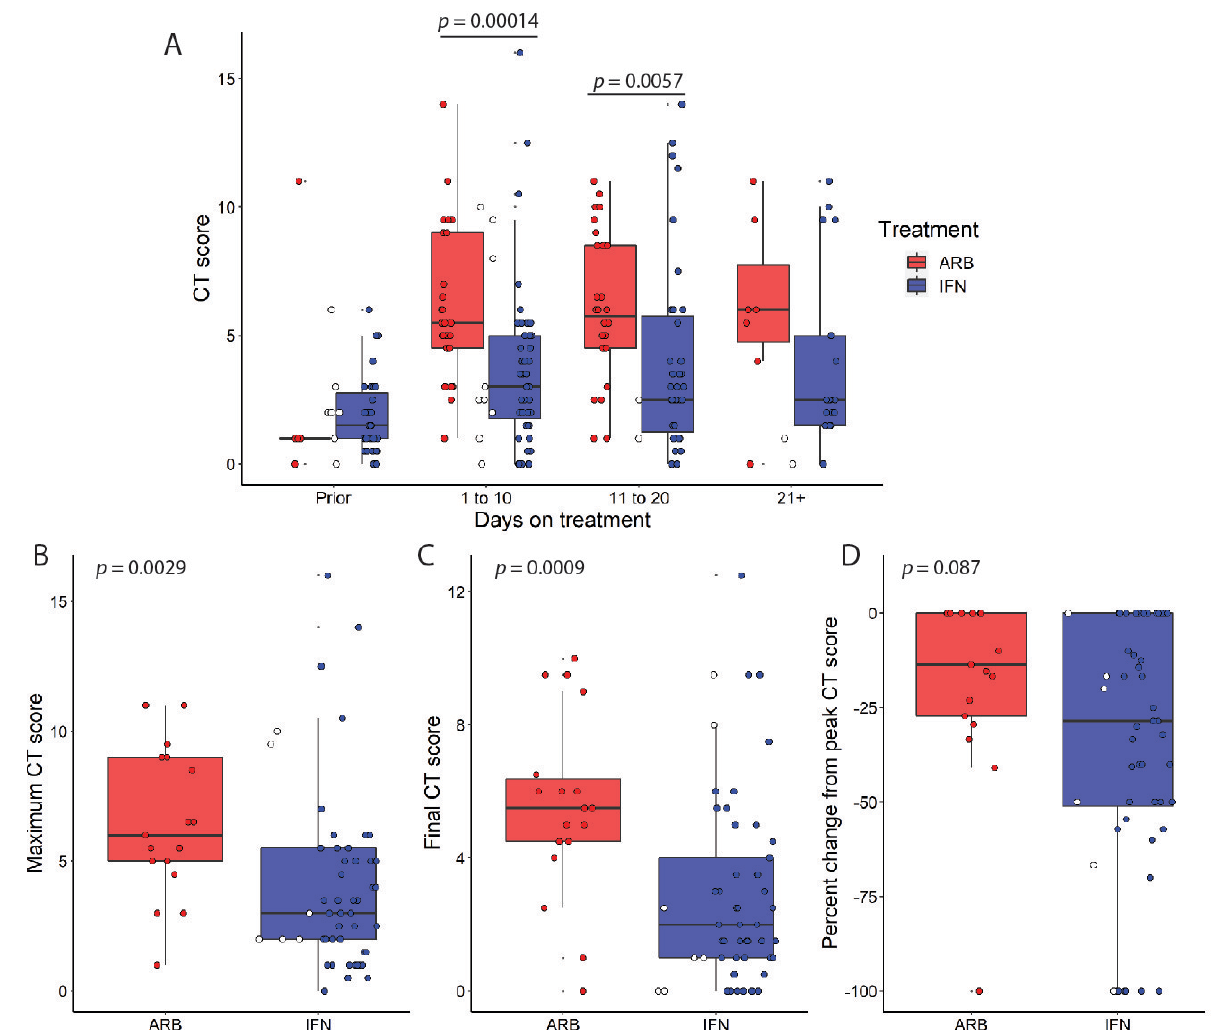
Figure 2. IFN- α 2b treatment reduces the severity of lung abnormalities in CT scans during the course of COVID-19. ( A ) COVID-19 cases were treated with either ARB alone (ARB, n = 24) or IFN- α 2b with or without ARB (IFN, n = 53). Data points for those cases treated with IFN alone are marked as open circles. Chest CT scores were recorded relative to treatment onset, as indicated. Each data point represents a score from a CT image; p values were calculated using thenon-parametric Mann–Whitney U test with Holm’s correction for multiple comparisons. Maximum ( B ), final ( C ), and ( D ) % change from peak CT scores are shown with p values calculated using Wilcoxon signed-rank